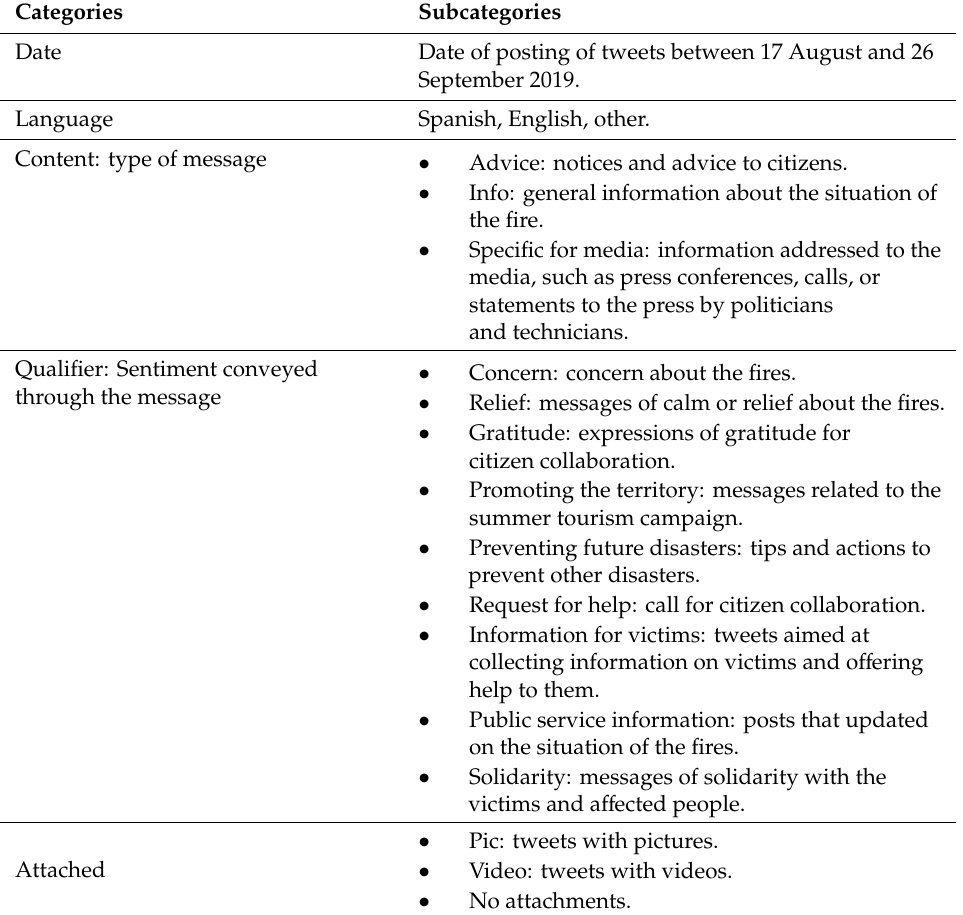
Table 2. Categories and subcategories of content analysis. Source: own elaboration, adapted from Crist ò fol, F.J.; de -San-Eugenio-Vela, J., and Paniagua-Rojano [67].